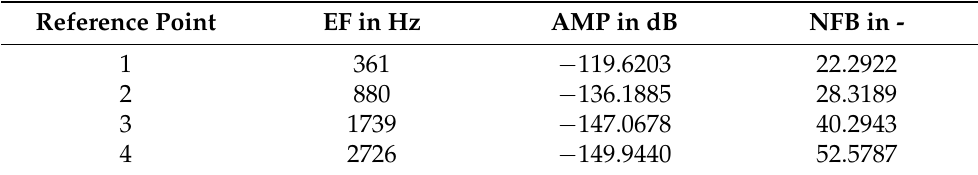
Table 3. List of the reference values of the numerical example.